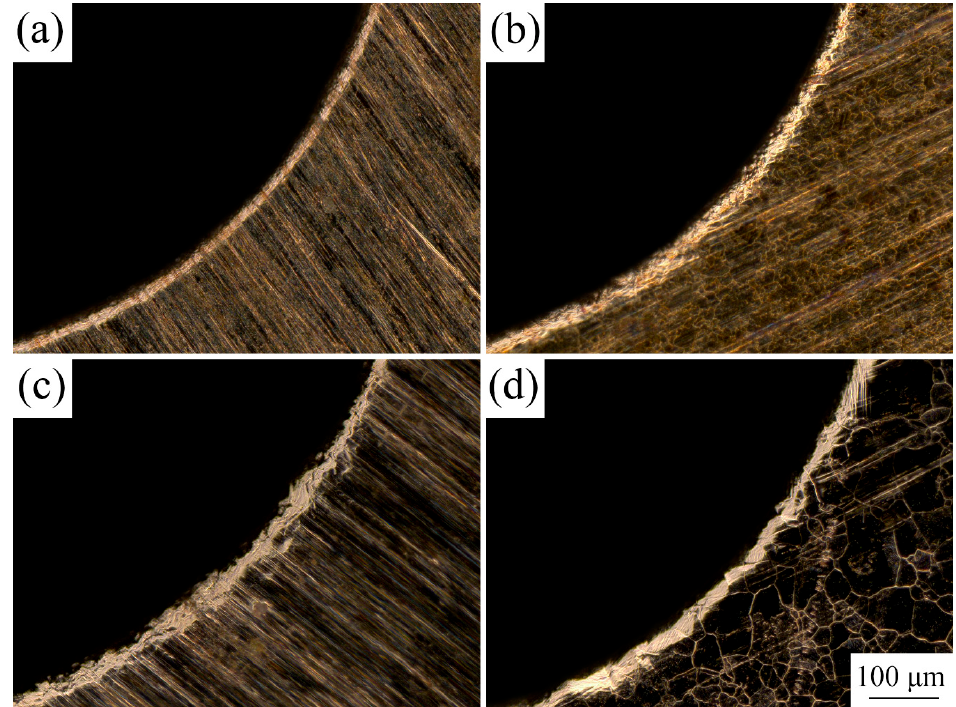
Figure 17. Comparison of punched holes without LPS under different conditions (upper surface). ( a )